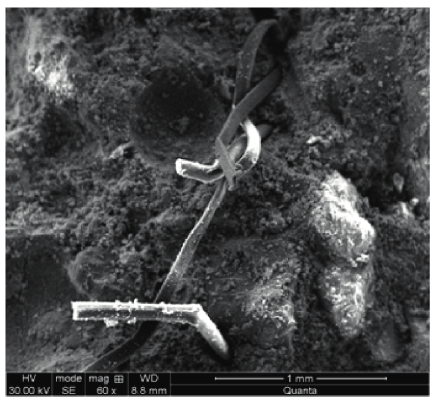
Figure 6: PP fibers inCGA